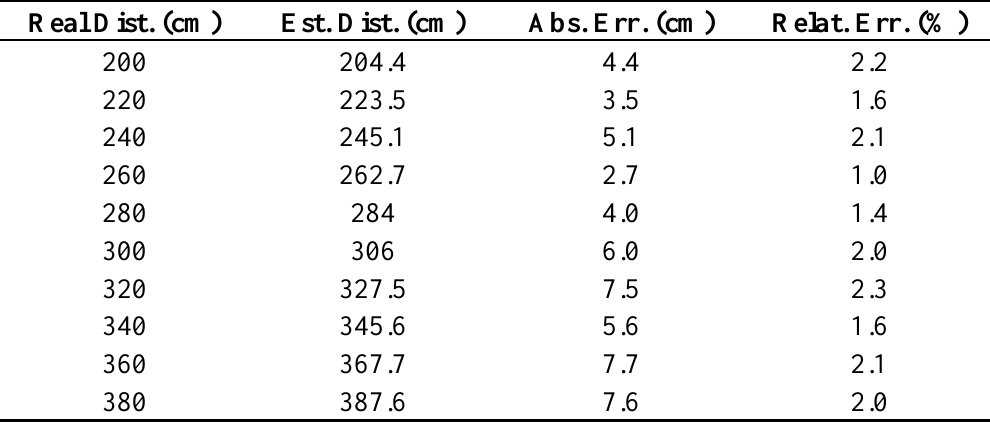
Table 1. Final distance estimation result for Experiment